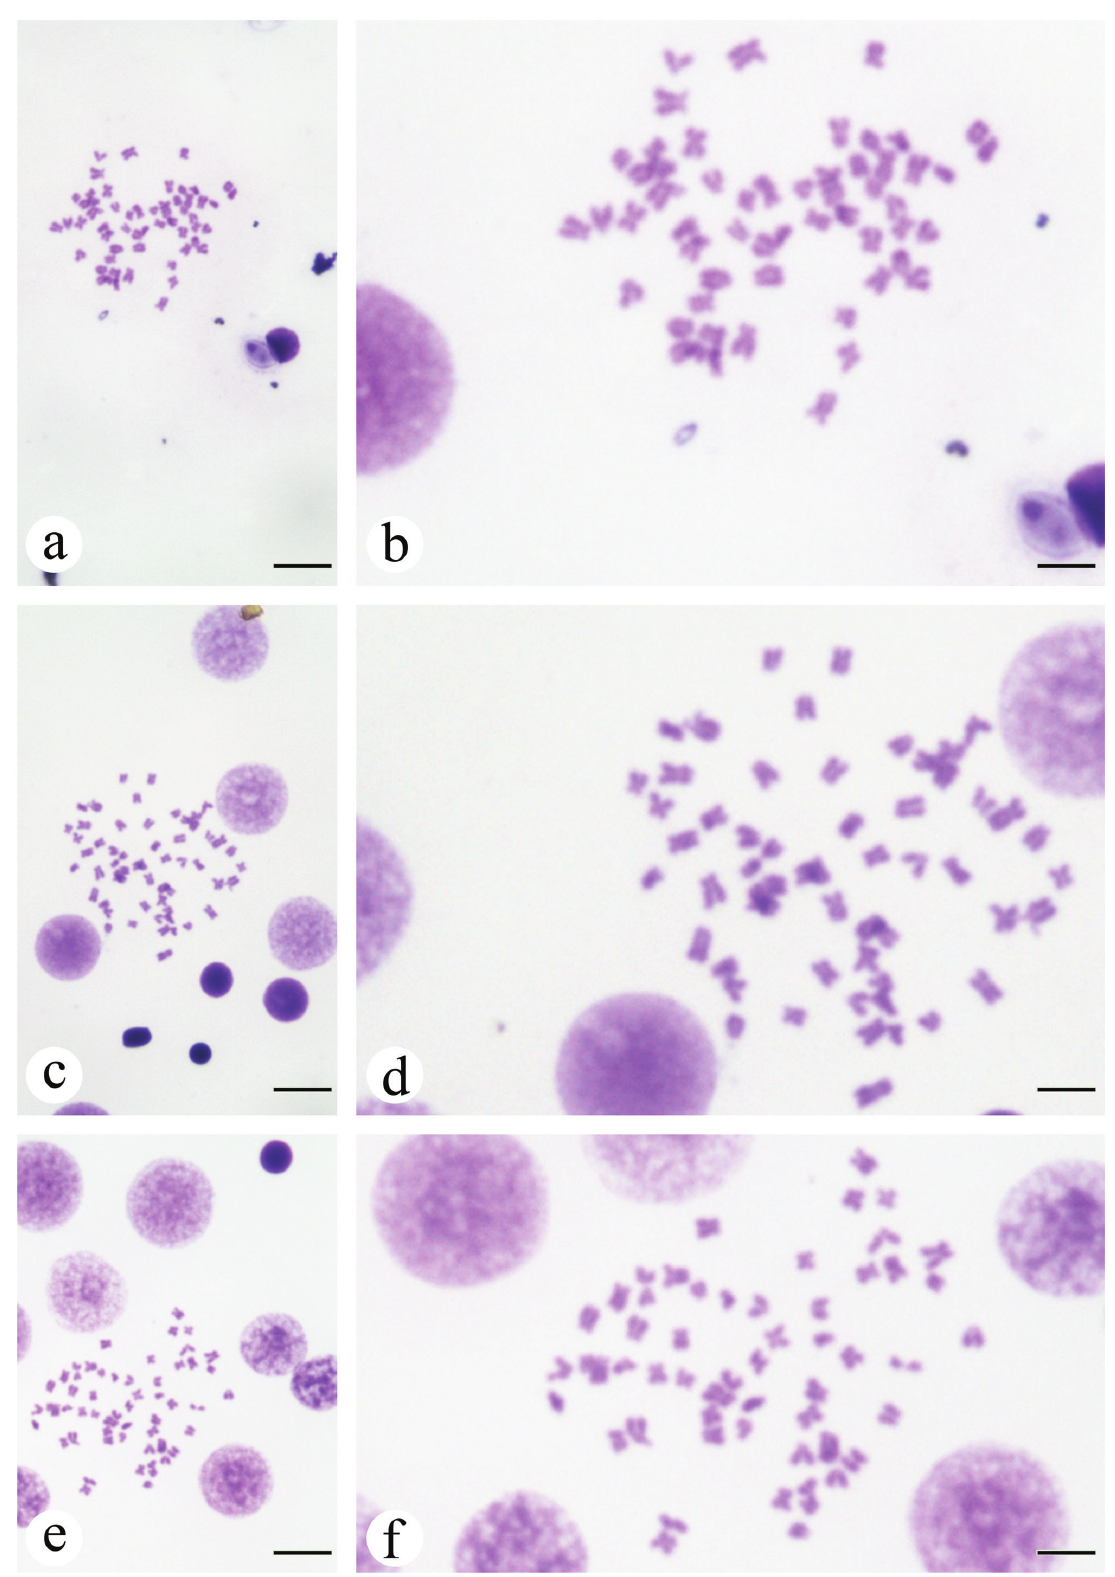
Fig. 4. Karyotype in Giemsa in male (a), detail in (b), in female (c), detail in (d) and in intersex animal (e), detail in (f) of Steindachneridion parahybae from Unidade de Hidrobiologia e Aquicultura, Companhia Energética de São Paulo. See the text for more information about karyotype characteristics. Scale bars: 37 μm (a,c,e); 7,4 μm